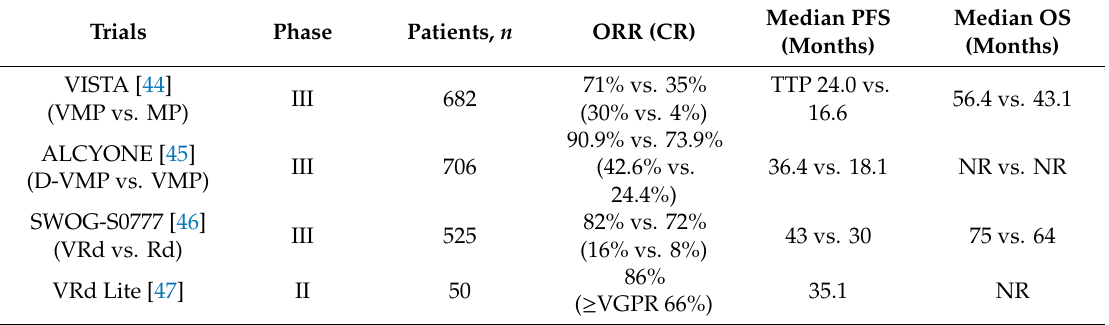
Table 3. Selected bortezomib-containing regimens for upfront treatment of transplant-ineligible